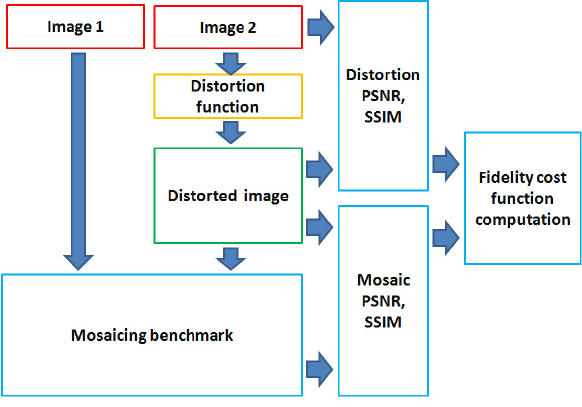
Figure 4. Fidelity computation